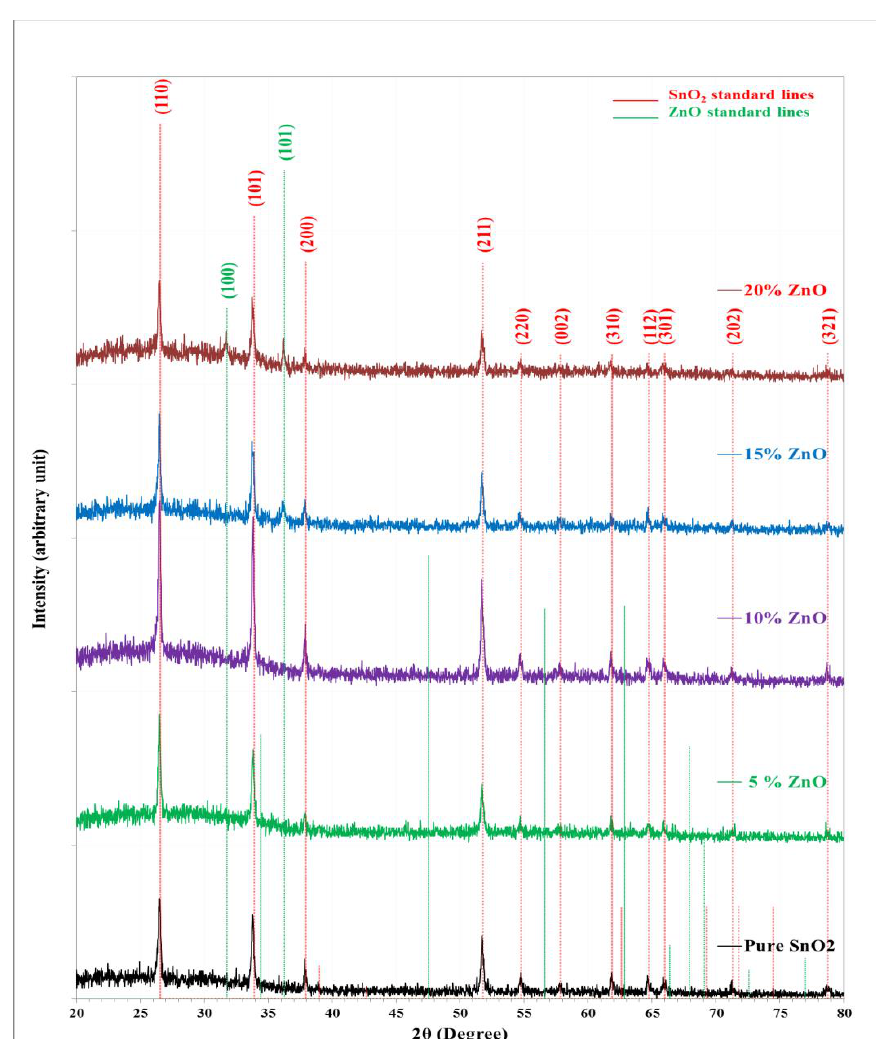
Fig.1: X-ray diffraction curves of pure SnO